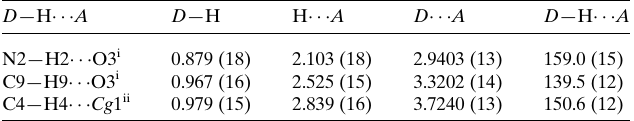
Table 1 Hydrogen-bond geometry (A˚ , (cid:2) ).